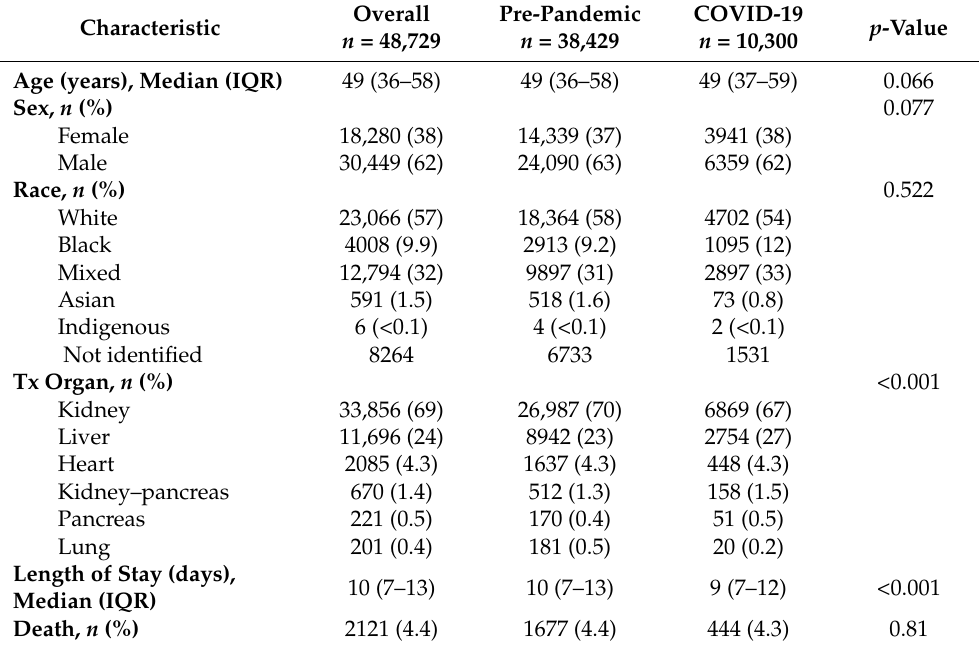
Table 2. Number of solid organ transplants performed in Unified Health System (SUS) in Brazil divided into pre-pandemic (January 2015 to March 2020) and COVID-19 pandemic (March 2020 to December 2021)